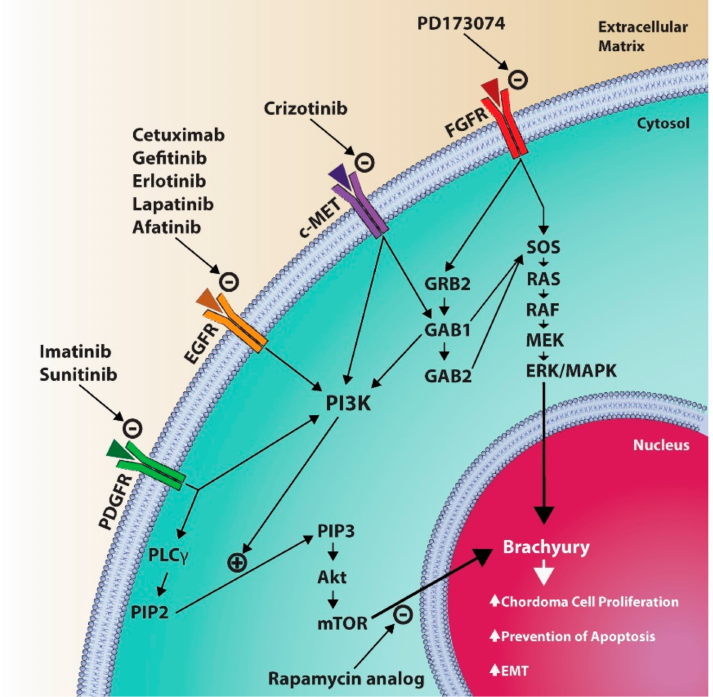
Figure 1. Diagram illustrating some of the molecular pathways involved in chordoma pathophys- iology. PDGFR, platelet-derived growth factor receptor; EGFR, epidermal growth factor receptor; c-MET, hepatocyte growth factor receptor; FGFR, fibroblast growth factor receptor; PLC γ , phos- pholipase C gamma; PIP2, phosphatidylinositol 4,5 bisphosphate; PIP3, phosphatidylinositol 3,4,5 triphosphate; Akt, active human serine/threonine protein kinase; mTOR, mammalian target of rapamycin; PI3K, phosphoinositide 3 kinases; GRB2, growth factor receptor bound protein 2; GAB1, GRB-associated binding protein 1; GAB2, GRB-associated binding protein 2; SOS, son of sevenless protein (guanine nucleotide exchange factor); RAS, rat sarcoma protein; RAF, rapidly accelerated fibrosarcoma protein; MEK, mitogen activated protein kinase kinase; ERK/MAPK, extracellular signal-related kinases/mitogen activated protein kinases; EMT, epithelial-mesenchymal